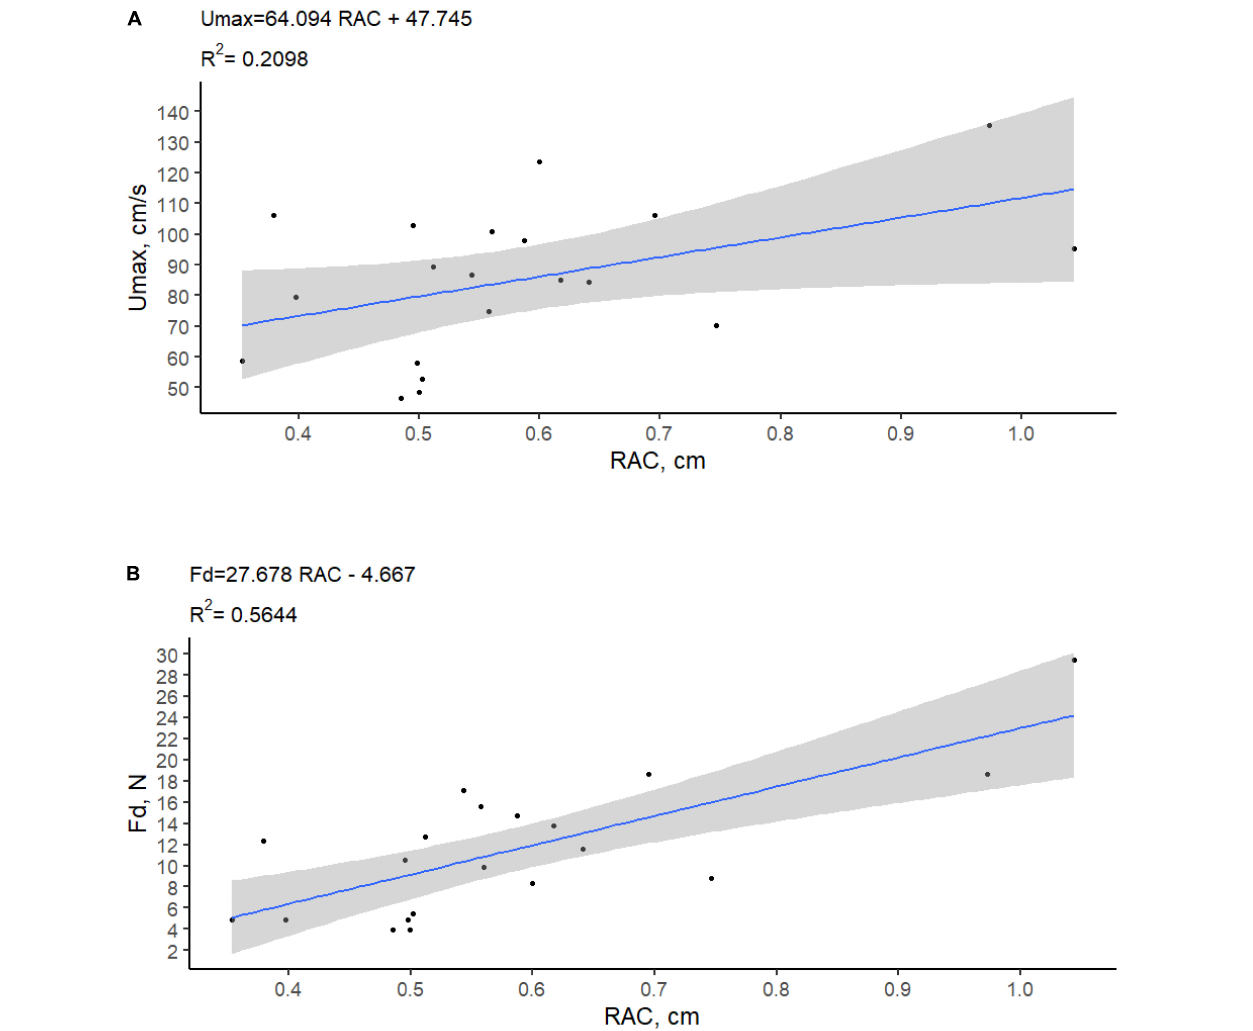
FIGURE 4 | Adhesion strength measured as (A) maximum flow velocity ( Umax, cm/s) and (B) pulling force ( Fd , N) required to detach P. oceanica seedlings according to the root adhesion capacity ( RAC ,